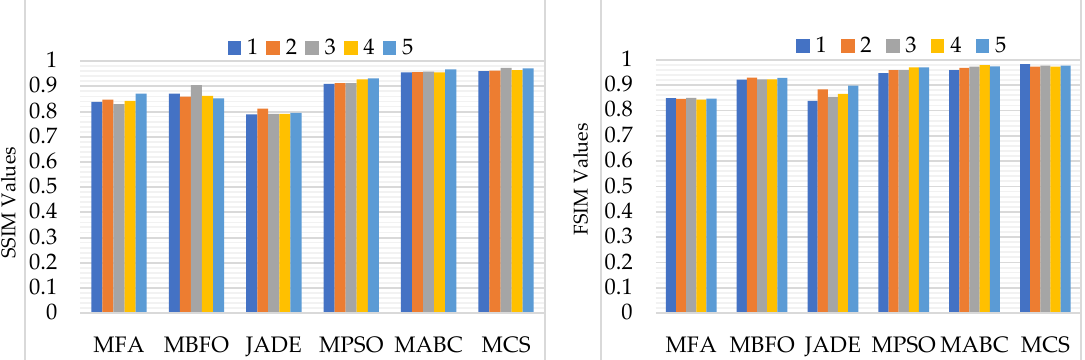
Figure 12. SSIM and FSIM using different optimization algorithms with GLCM.